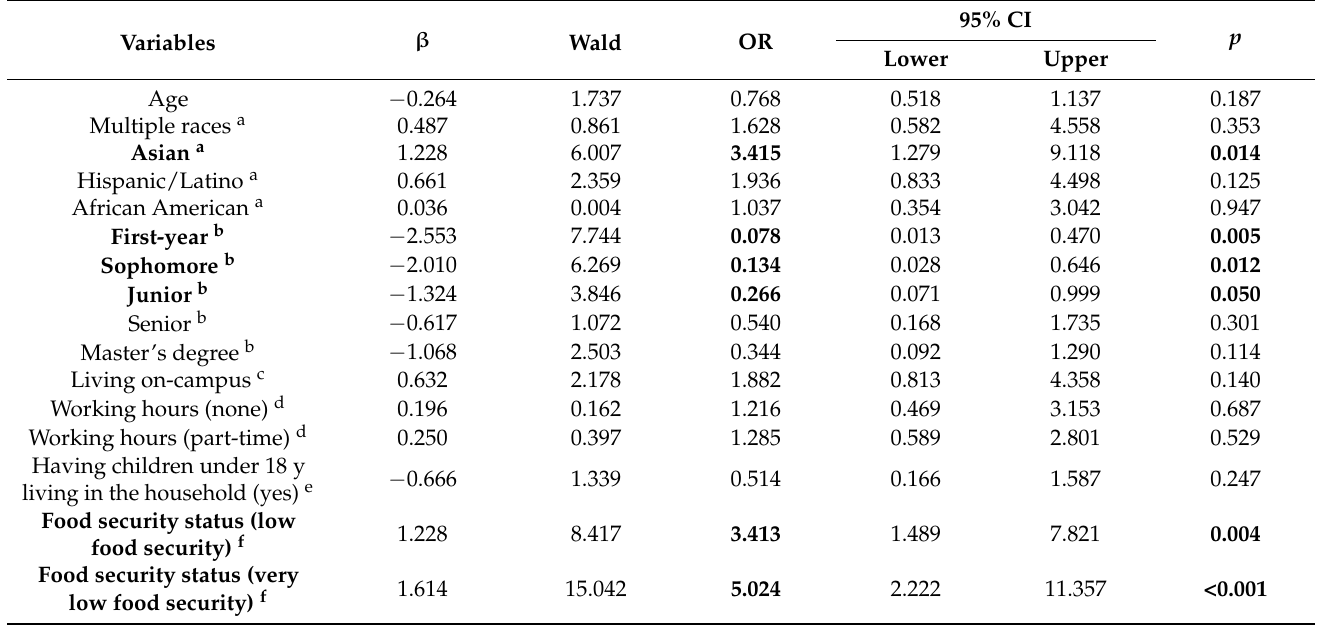
Table 4. Summary of Logistic Regression Predicting Food Pantry Use by Demographic Factors and Food Security Status.